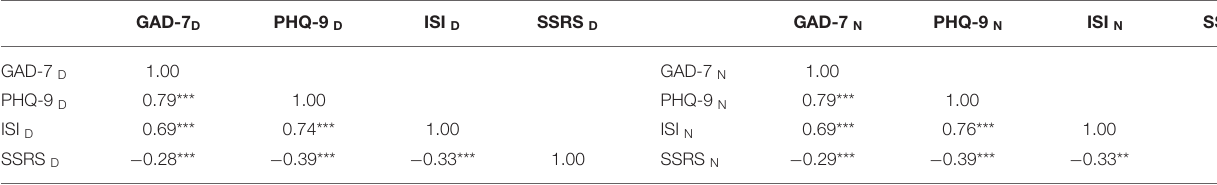
TABLE 3 | The partial correlation of each scale of first-line doctors and nurses.